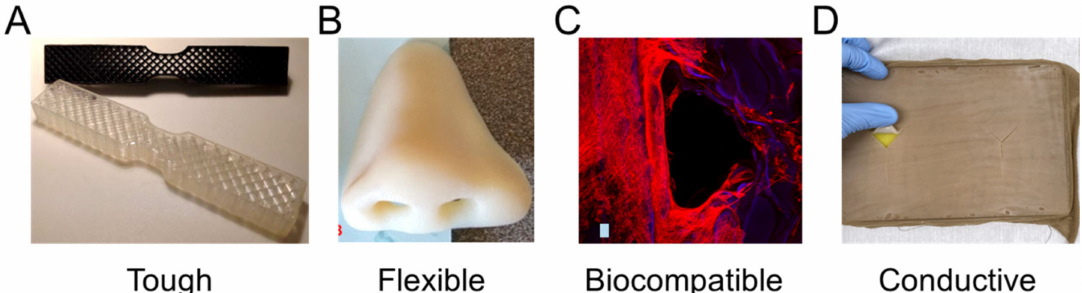
Figure 2. Materials with highlighted properties for ( A ) toughness [26], ( B ) flexibility [28], ( C ) biocompatibility [30], and ( D ) conductivity [31]. Images adapted with